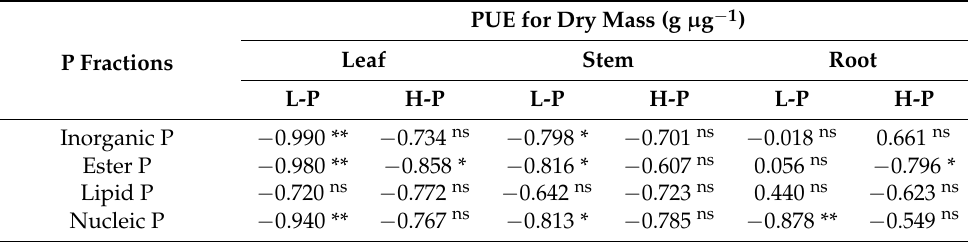
ns Represents not significant with p > 0.05, * represents significant differences at p < 0.05, ** represents sig- nificant differences at p < 0.01; PUE represents P use efficiency, L-P and H-P represent the low-P and high-P treatments,